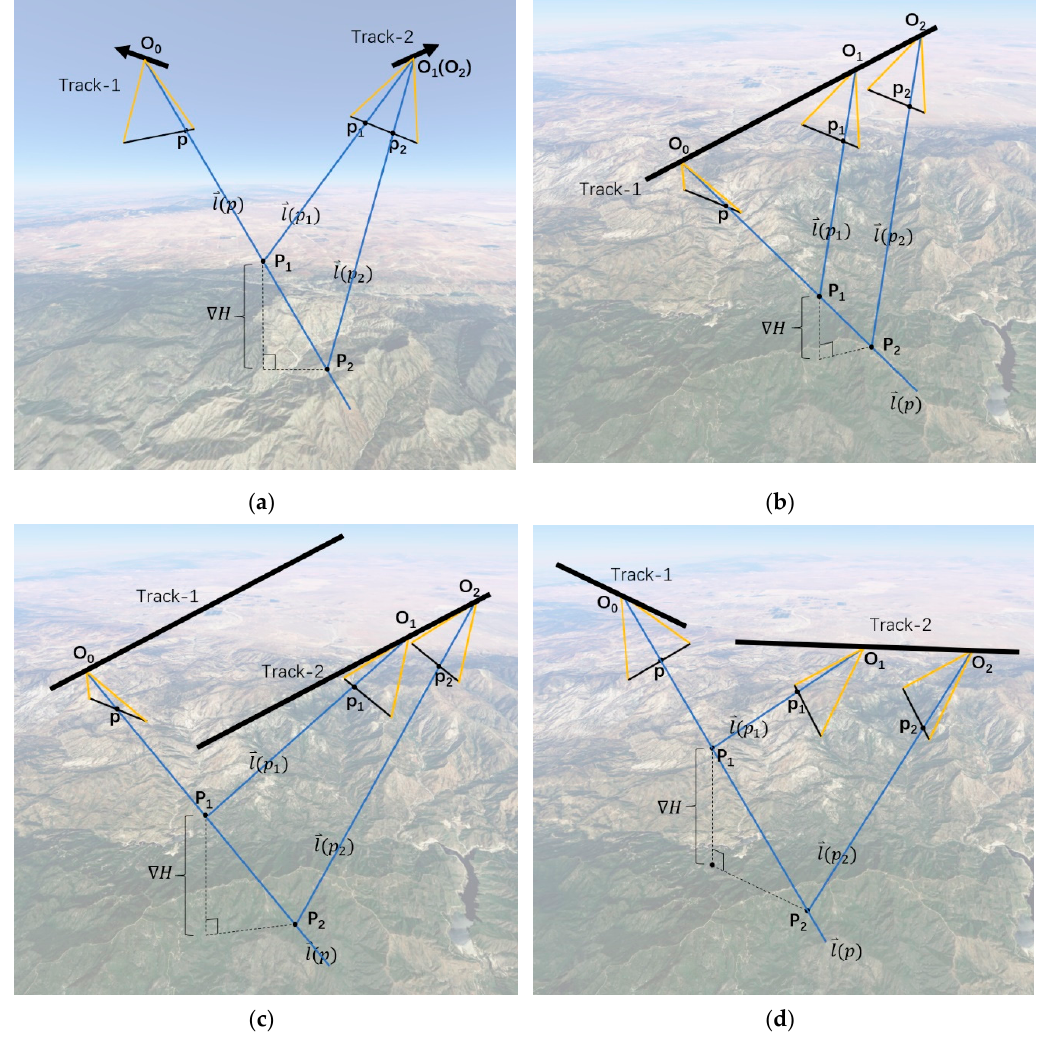
Figure 1. Four typical types of geometric relationships of pushbroom stereo images: ( a ) cross-track coplanar stereo; ( b ) along-track stereo; ( c ) cross-track non-coplanar stereo; and ( d ) cross-multi- directional-track stereo.